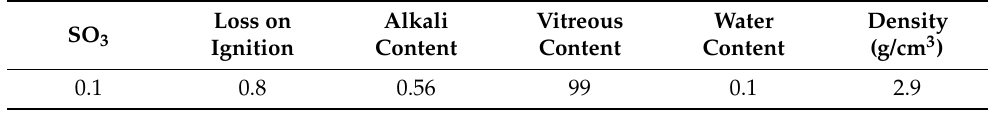
Table 2. The chemical constituents of slag.